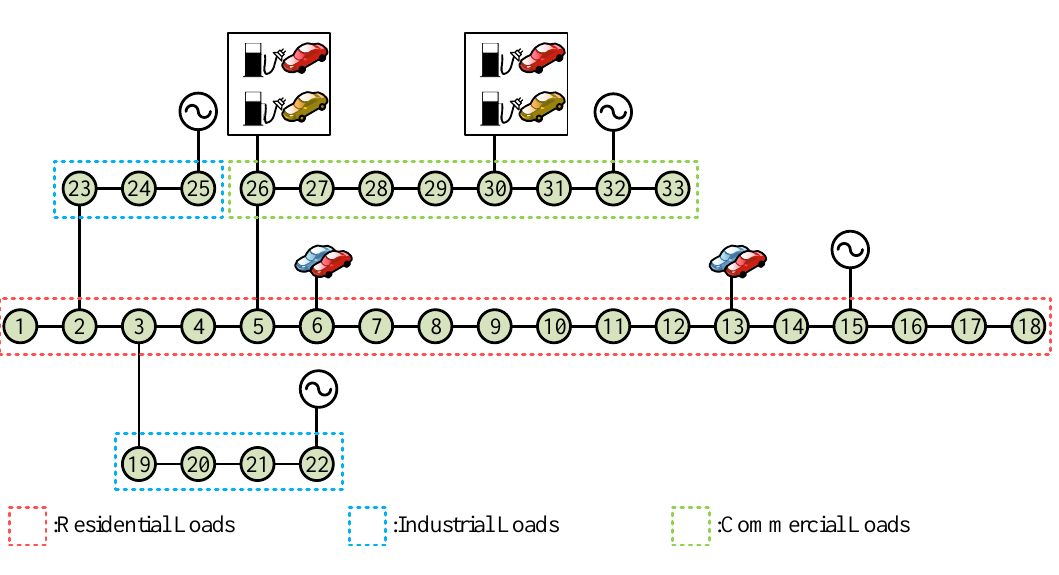
Figure 2. The modified IEEE 33-bus distribution